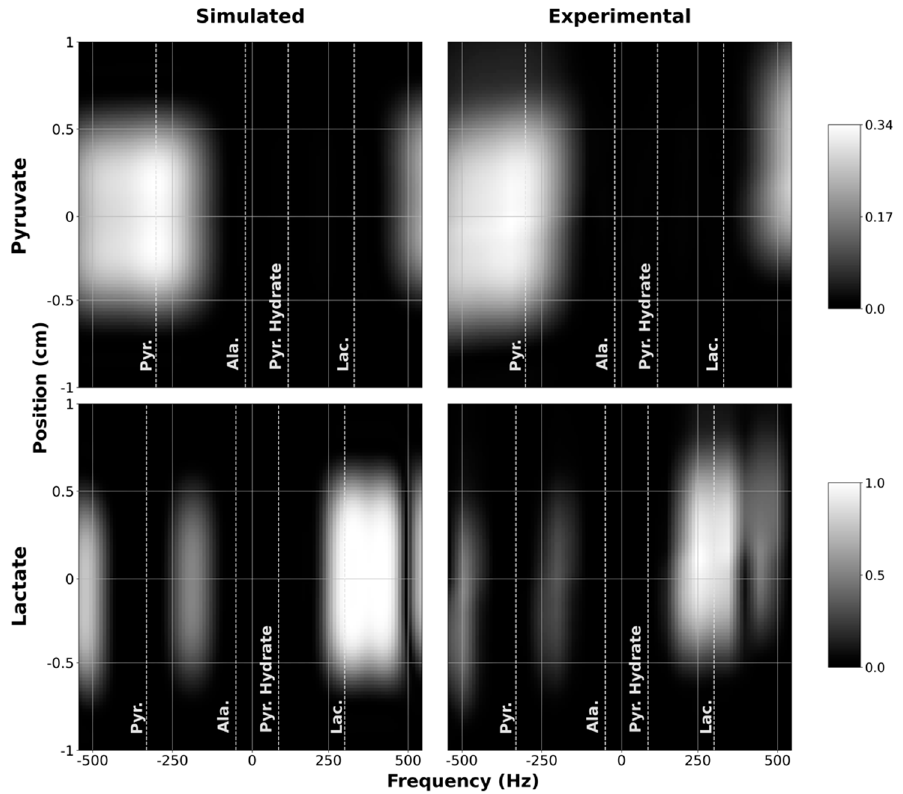
Figure 3. Simulated (1st column) and measured (2nd column) spectral ‐ spatial profiles for pyruvate (1st row) and lactate (2nd row). Measured profiles were obtained by sweeping the scanner center frequency from − 600 to +600 Hz. For display purposes, the measured profiles were interpolated onto the same grid points as the simulated profiles.